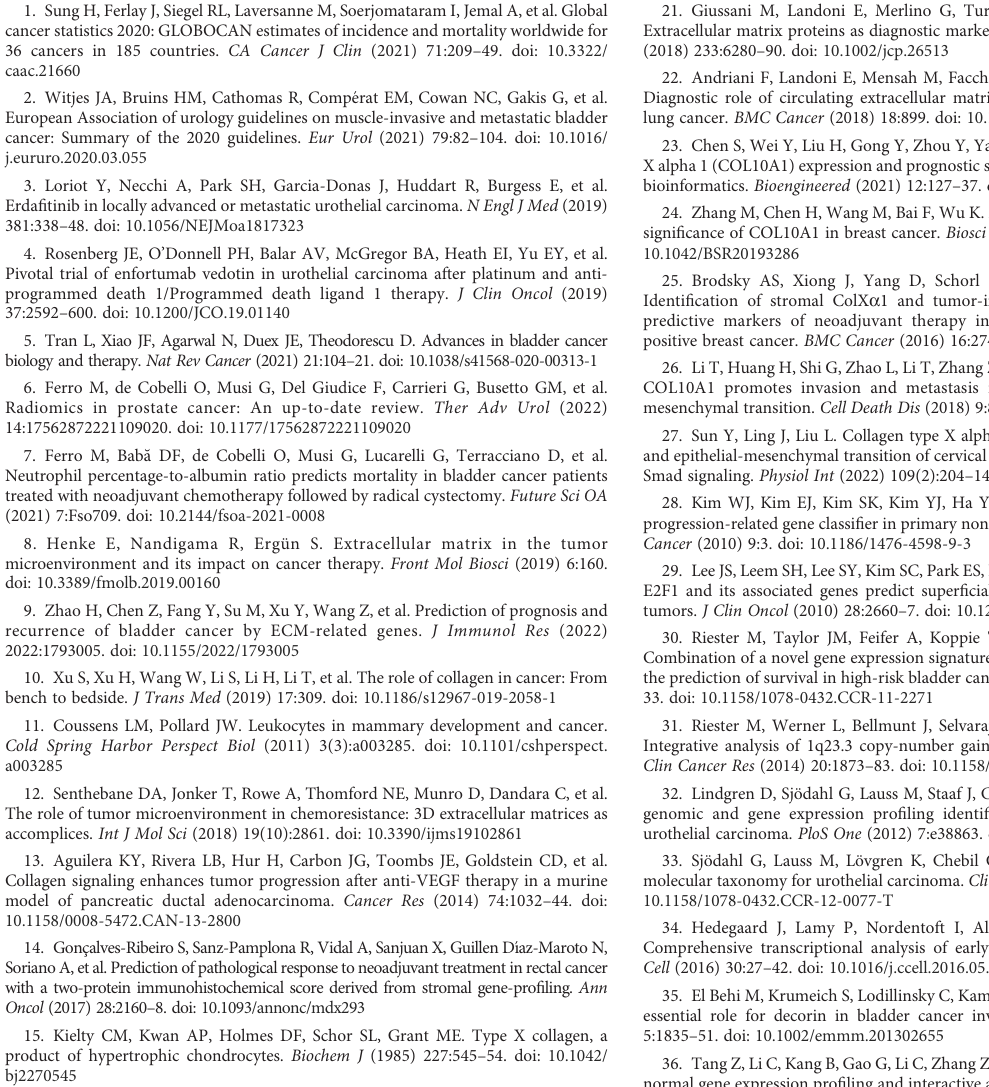
SUPPLEMENTARY FIGURE 2 The optimal cutoff value was used to create a categorical dependent variable based on COL10A1 expression in TCGA (A) , GSE13507 (B) , GSE31684 (C) ,